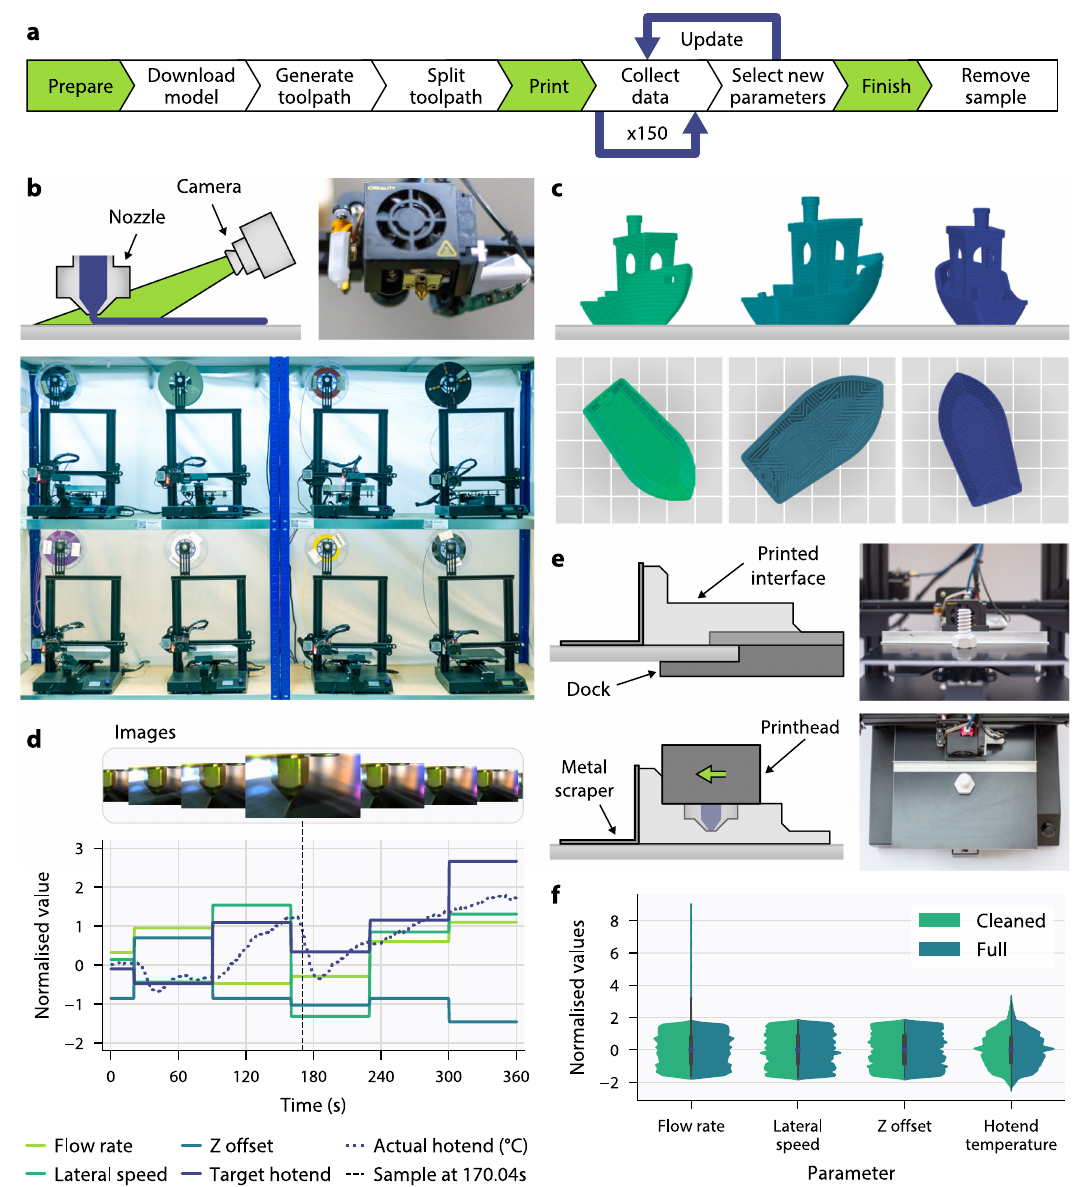
Fig. 1 | Overview of the CAXTON system used for automated data collection. a Work fl ow for collecting varied datasets from extrusion 3D printers with the automatic labelling of images with printing parameters. b Fleet of eight thermo- plastic extrusion 3D printers (Creality CR-20 Pro) equipped with cameras focused on the nozzle tip to monitor material deposition. c Renderings of generated tool- paths for a single input geometry, with randomly selected slicing parameters.